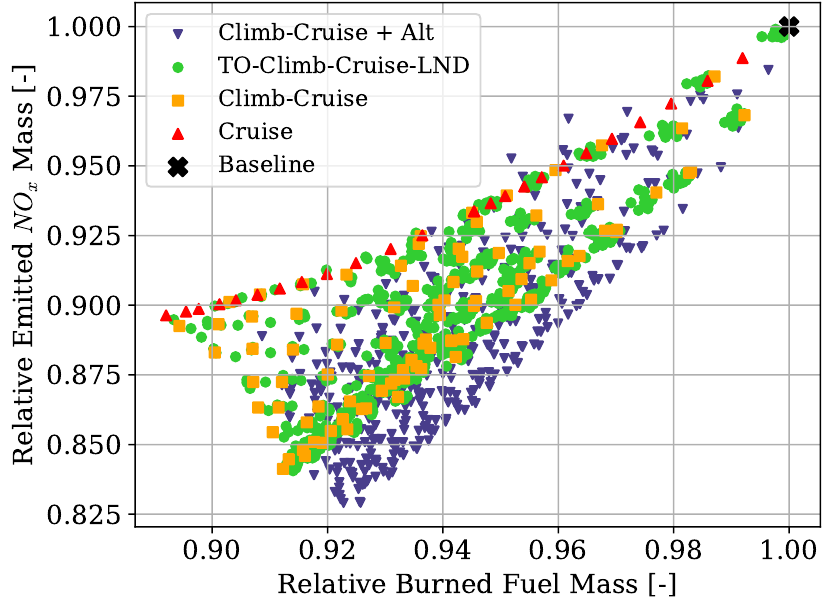
Figure A3. Objective space of Uniform strategies with different hybridised mission phases.